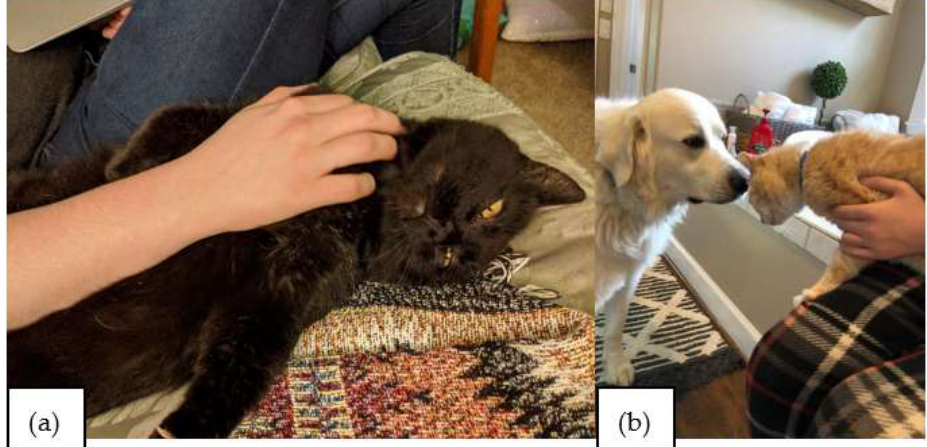
Figure 1. Results of the written survey to track which activities volunteers reported engaging in with their foster cats during their stay at the foster home.